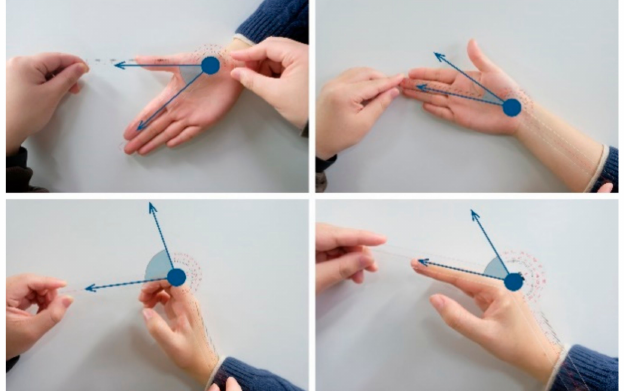
Figure 9. Measurement of the motion angle of the motion primitive units. The blue sector marks the measured